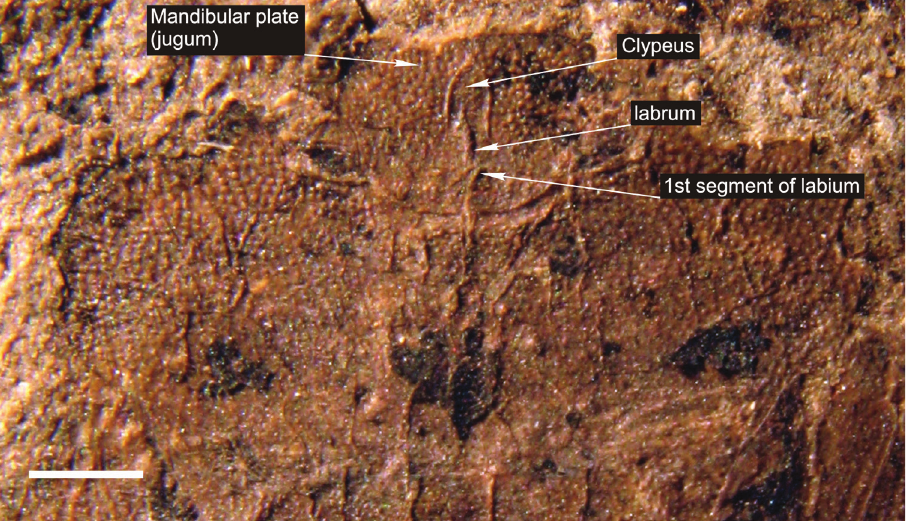
Figure 2. Photograph of detail of head and thorax of Acanthocephalonotum martinsnetoi gen. n. et sp. n. Holotype specimen MAPBAR 4137. Scale bar represents 1